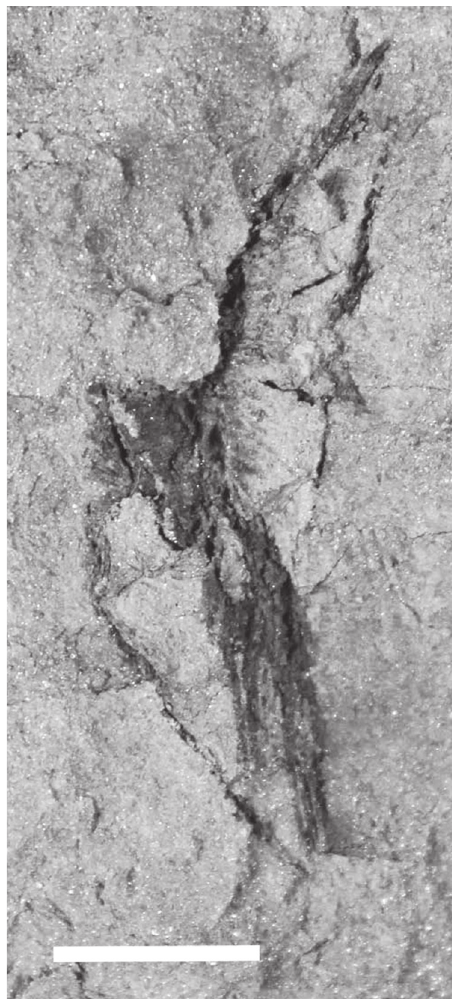
Figure 7 - UEPG/DEGEO/MPI 10548. Poorly preserved remains of a fin showing only impressions (natural casts) of radial elements. Scale=